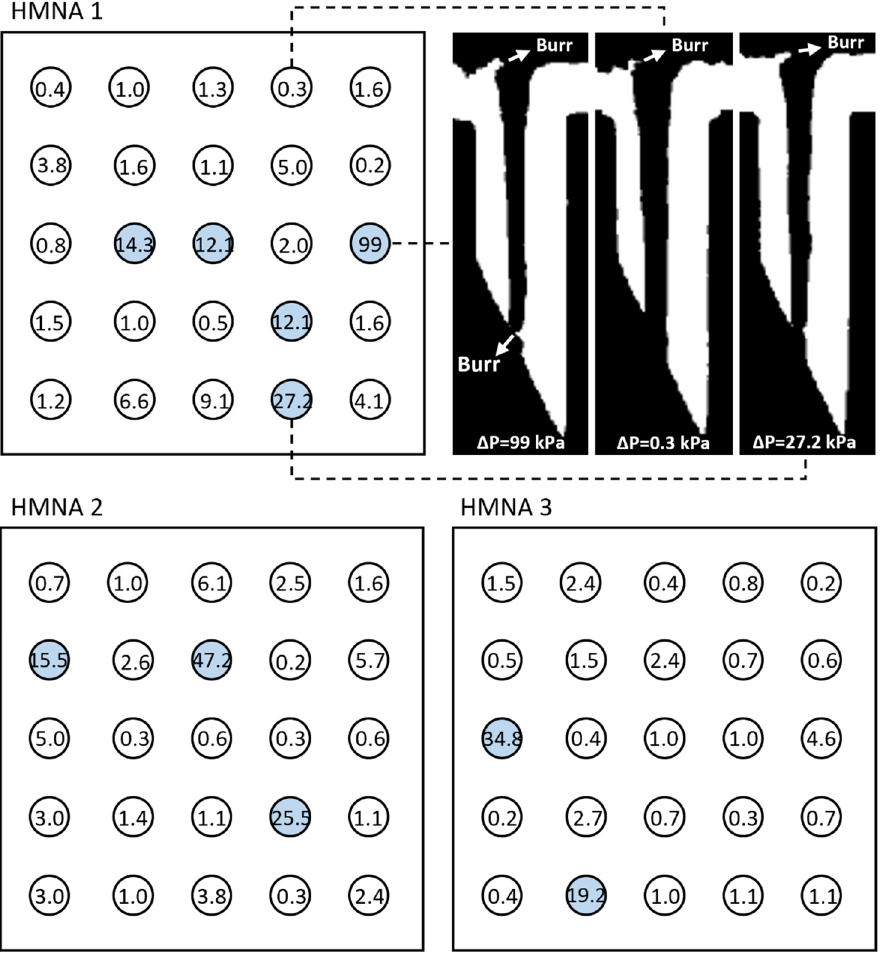
Figure 5. Spatial distribution of the measured average ( n = 3) pressure drops (kPa) for 3 different arrays at the flow rate of 50 μ L/min. Pressure drops > 10 kPa are indicated in blue. For information